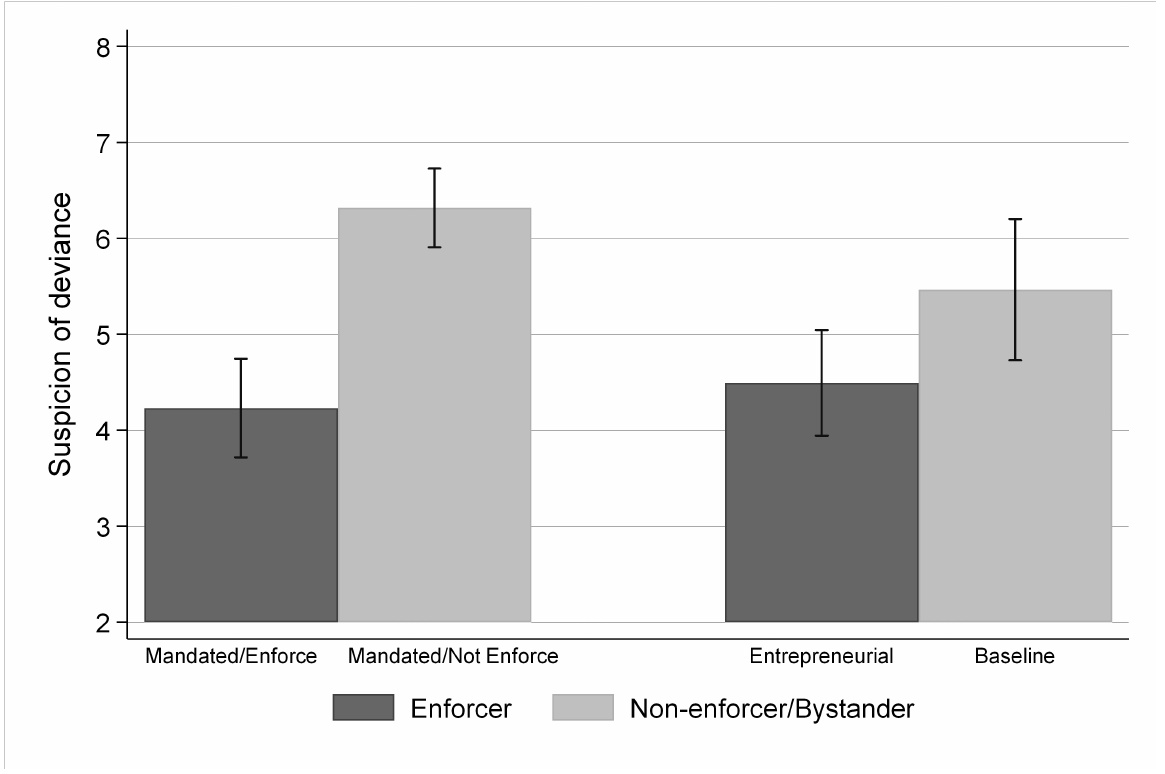
Figure 4: Between-subject comparison of perceived likelihood that student 6 changed his response in study 2. The error bars indicate the 95 percent confidence interval. Possible values of the y axis range from 1 (very unlikely) to 10 (very likely). The measure is the response to the question “How likely is it that Student X ban alcohol on its